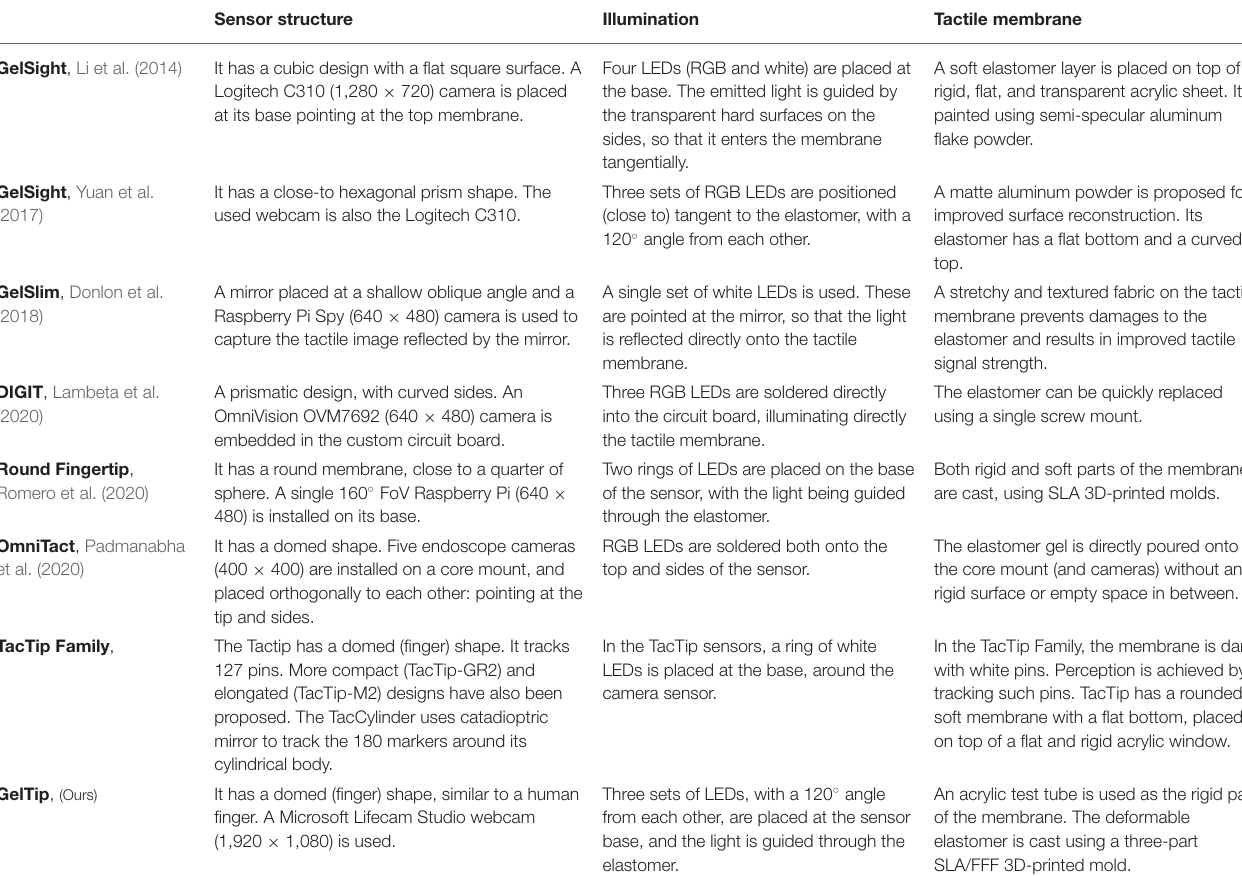
TABLE 1 | A summary of influential GelSight sensors, the TacTip family, and our GelTip sensor. Sensor